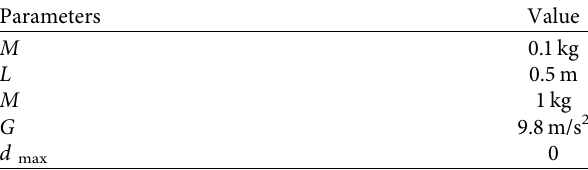
Table 5: Specifications of the cart-pole system.